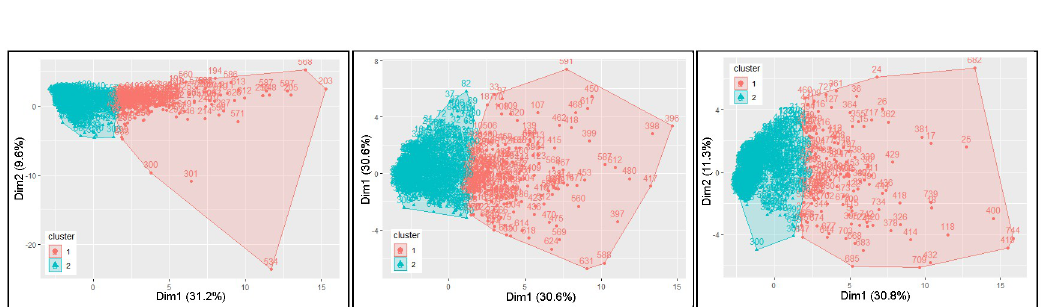
Fig 7. 2-dimensional cluster plots for Cattle Egret, Straw-necked Ibis, and Nankeen Kestrel. The axes for these plots are the principal components of the multi-dimensional vectors used as input to the K-means algorithm. (a) Cluster results for Cattle Egret where k = 2. Cluster 1 includes 187 days, cluster 2 includes 574 days. (b) Cluster results for Straw-necked Ibis where k = 2. Cluster 1 includes 191 days, cluster 2 includes 570 days. (c) Cluster results for Nankeen Kestrel where k = 2. Cluster 1 includes 130 days, cluster 2 includes 631 days.